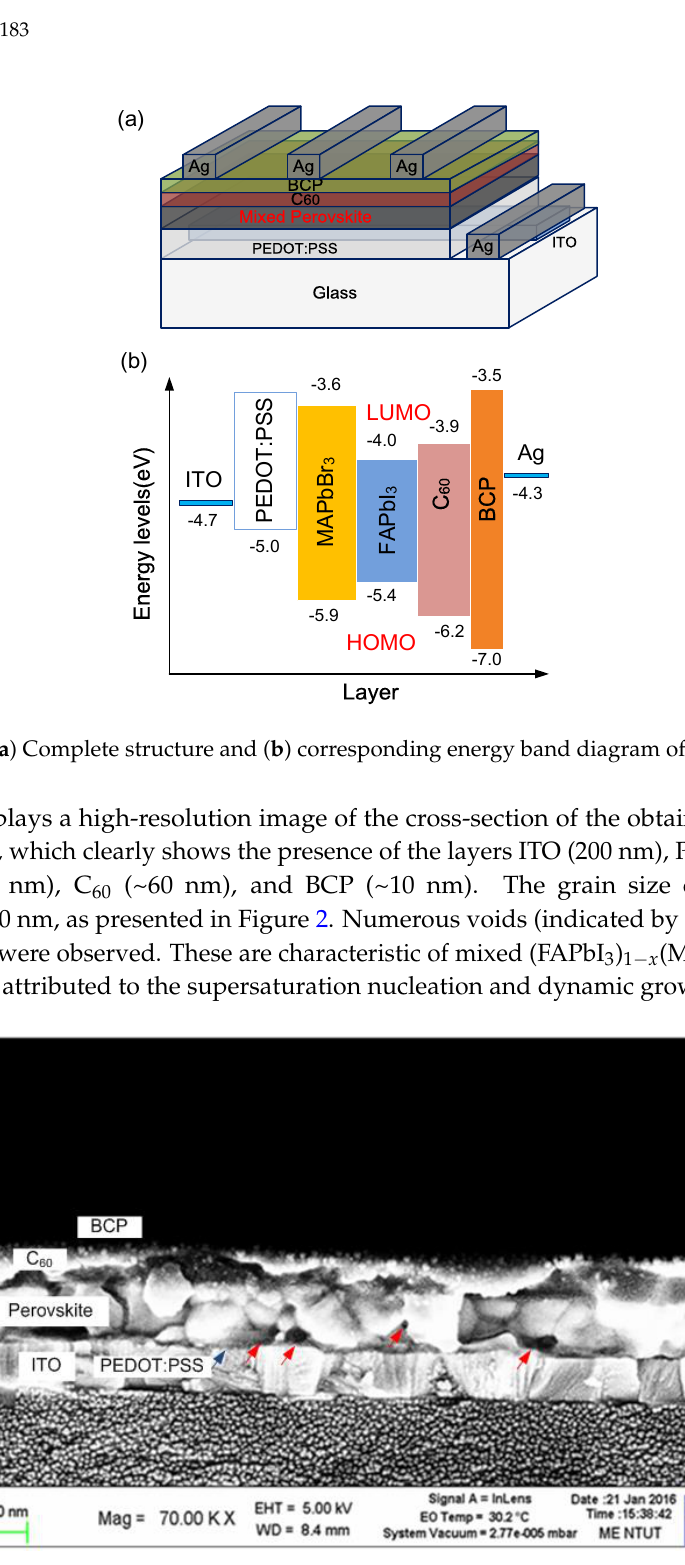
Figure 2. Field emission scanning electron microscope (FESEM) cross-sectional image of device structure.